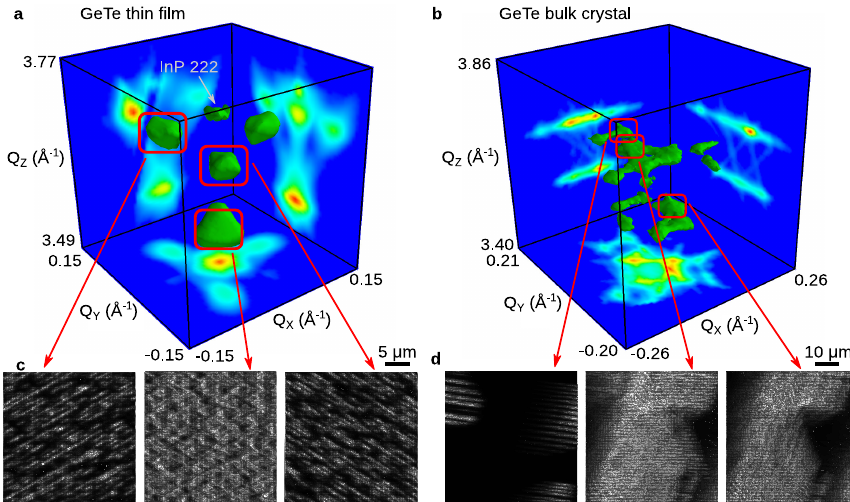
Figure 2. ( a , b ) three-dimensional X-ray diffraction reciprocal space maps of GeTe thin films ( a ) and GeTe bulk crystals ( b ) around the 222 Bragg peak. In the case of thin films, the 222 Bragg peak of the single crystalline InP(111) substrate is also seen. Selected regions of reciprocal space, indicated by red boxes, were mapped in real space resulting in the scanning X-ray micrographs shown in panels ( c , d